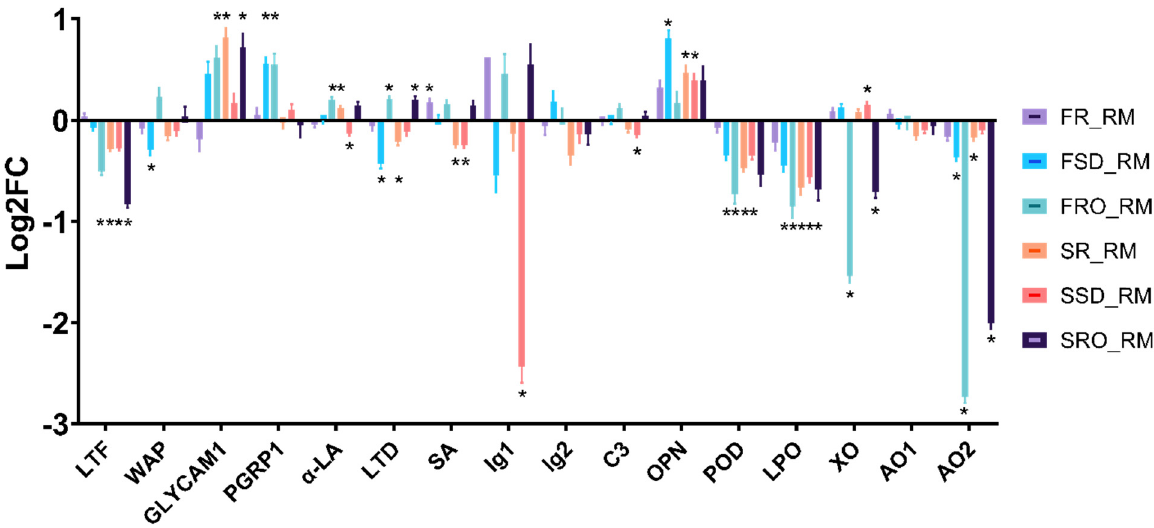
Figure 6. Fold change of bioactive proteins in the camel milk powders produced. LTF, Lactotransferrin (W6GH05); WAP, whey acidic protein (P09837); GLYCAM1, glycosylation-dependent cell adhesion molecule 1 (P15522); PGRP1, peptidoglycan recognition protein 1 (Q9GK12); α -LA, α -lactalbumin (S9YFK0); LTD, lactadherin (S9WF76); SA, serum albumin (S9WI87); Ig1, Ig-like domain-containing protein (S9X0W6); Ig2, Ig γ -3 chain C region (S9XBS9); C3, complement C3 (S9XDK9); OPN, osteo- pontin (S9XC74); POD, peroxidase (Q9GJW6); LPO, lactoperoxidase (S9X7Q1); XO, xanthine oxidase (S9Y4T1); AO1, amine oxidase (S9XJ18); AO2, amine aoxidase (S9Z0L8). UniProt accession numbers are given in brackets. RM, raw milk; FR, freeze-dried raw milk powder; FSD, spray-dewatering- concentrated/freeze-dried milk powder; FRO, reverse-osmosis-concentrated/freeze-dried milk pow- der; SR, spray-dried raw milk powder; SSD, spray-dewatering-concentrated/spray-dried milk pow- der; SRO, reverse-osmosis-concentrated/spray-dried milk powder. * indicates the change directly above or below it is significant ( p < 10 − 5